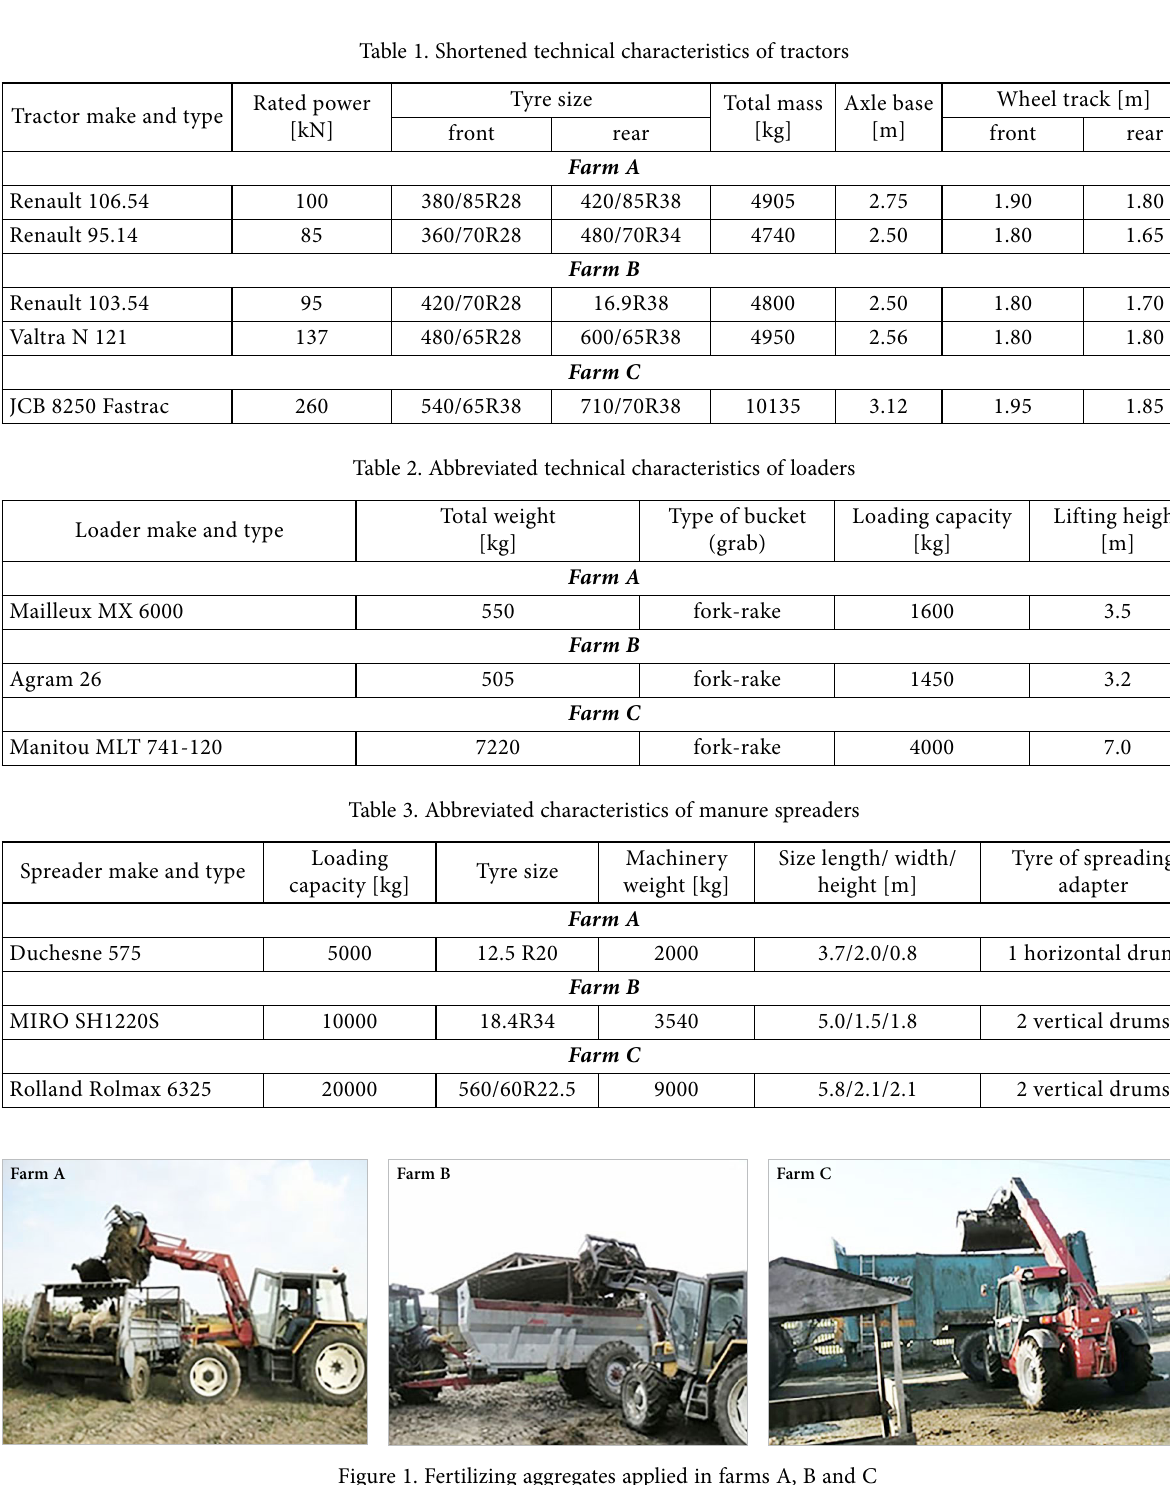
Figure 1. Fertilizing aggregates applied in farms A, B and